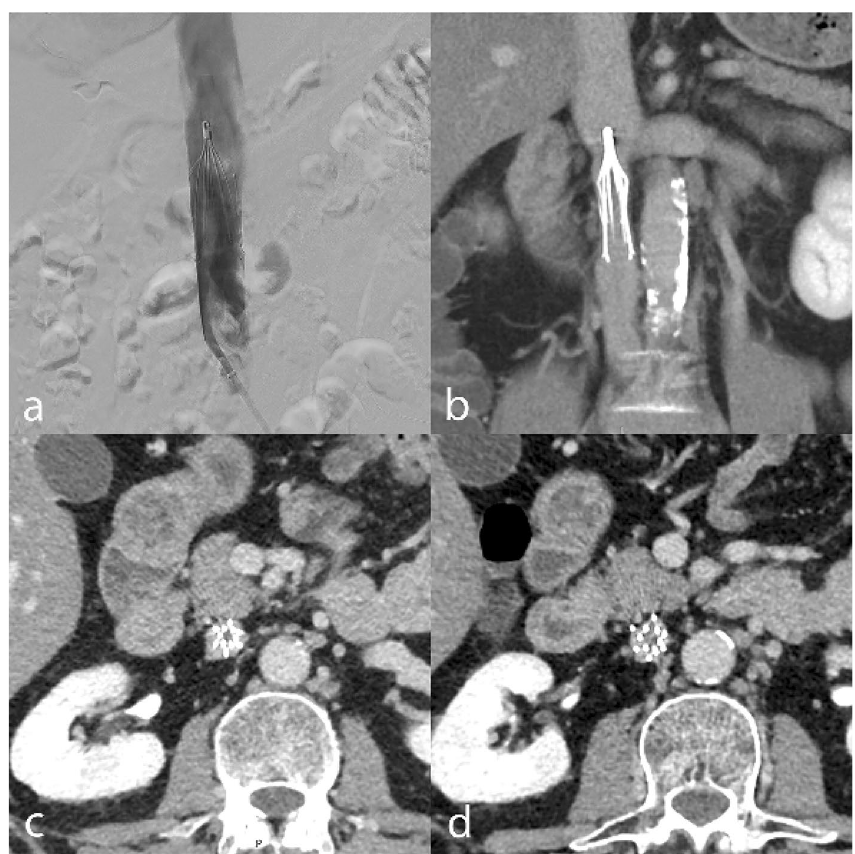
Figure 3. Post-deployment subtracted cavography shows IVCF positioned in infrarenal position and absence of IVC stenosis, in a patient with femoral and iliac DVT under ACT ( a ); CT venography obtained 5 months later shows IVC stenosis on coronal reformatted image ( b ), and thrombus trapped inside the IVCF ( c , d ), leading to technical ineligibility for retrieval. ACT anticoagulation therapy, CT computed tomography, DVT deep venous